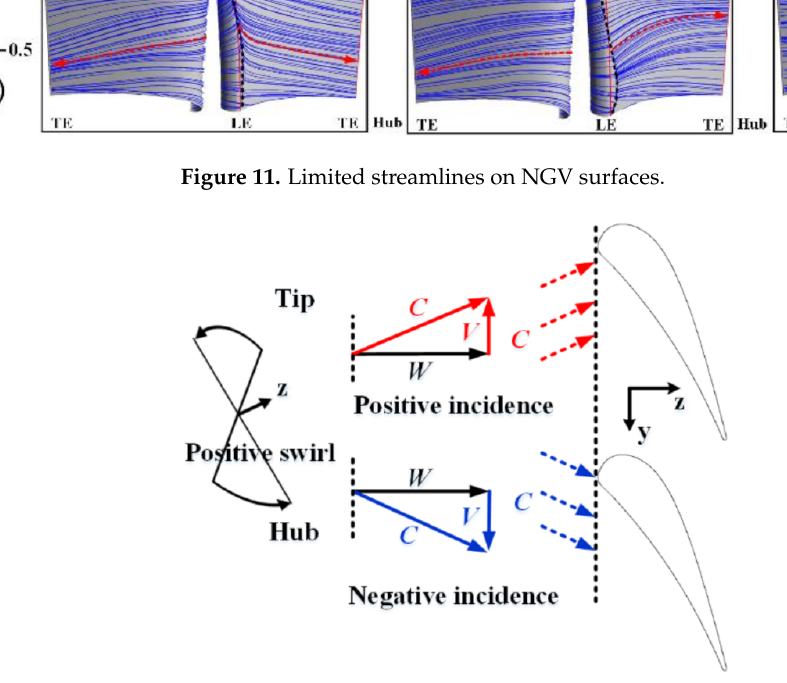
Figure 12. Change in incidence angle due to positive